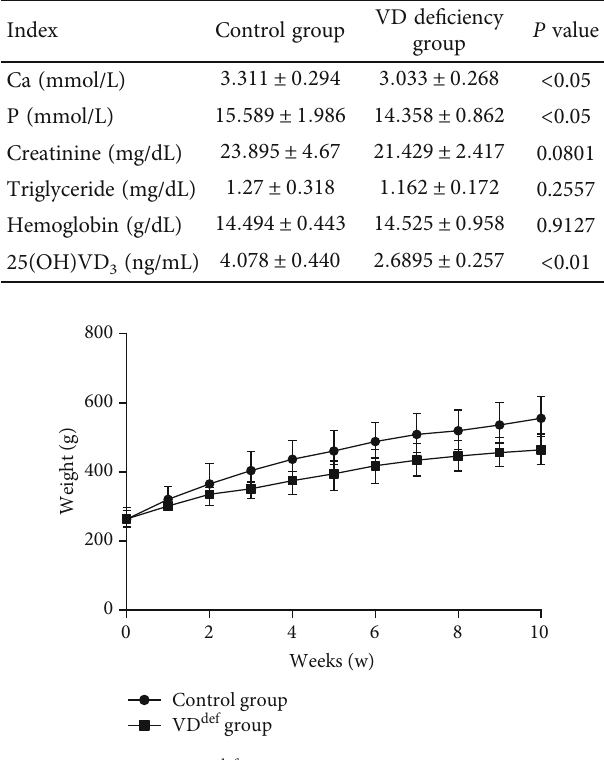
Figure 1: E ff ects of VD def on body weight in rats. The red triangle represents the weight of the control group, and the blue triangle represents the weight of VD def group. ∗ P < 0 : 05 vs. the control